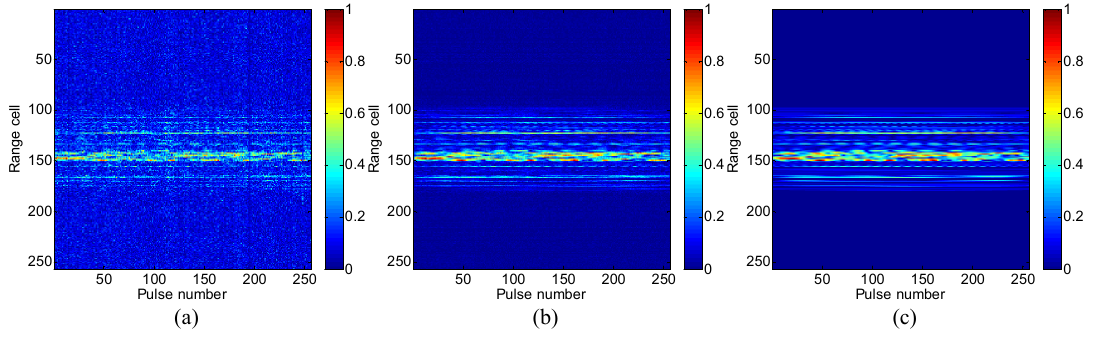
Figure 7. Range profiles of Yak-42 with SNR = 0 dB: ( a ) original; ( b ) LB; ( c )